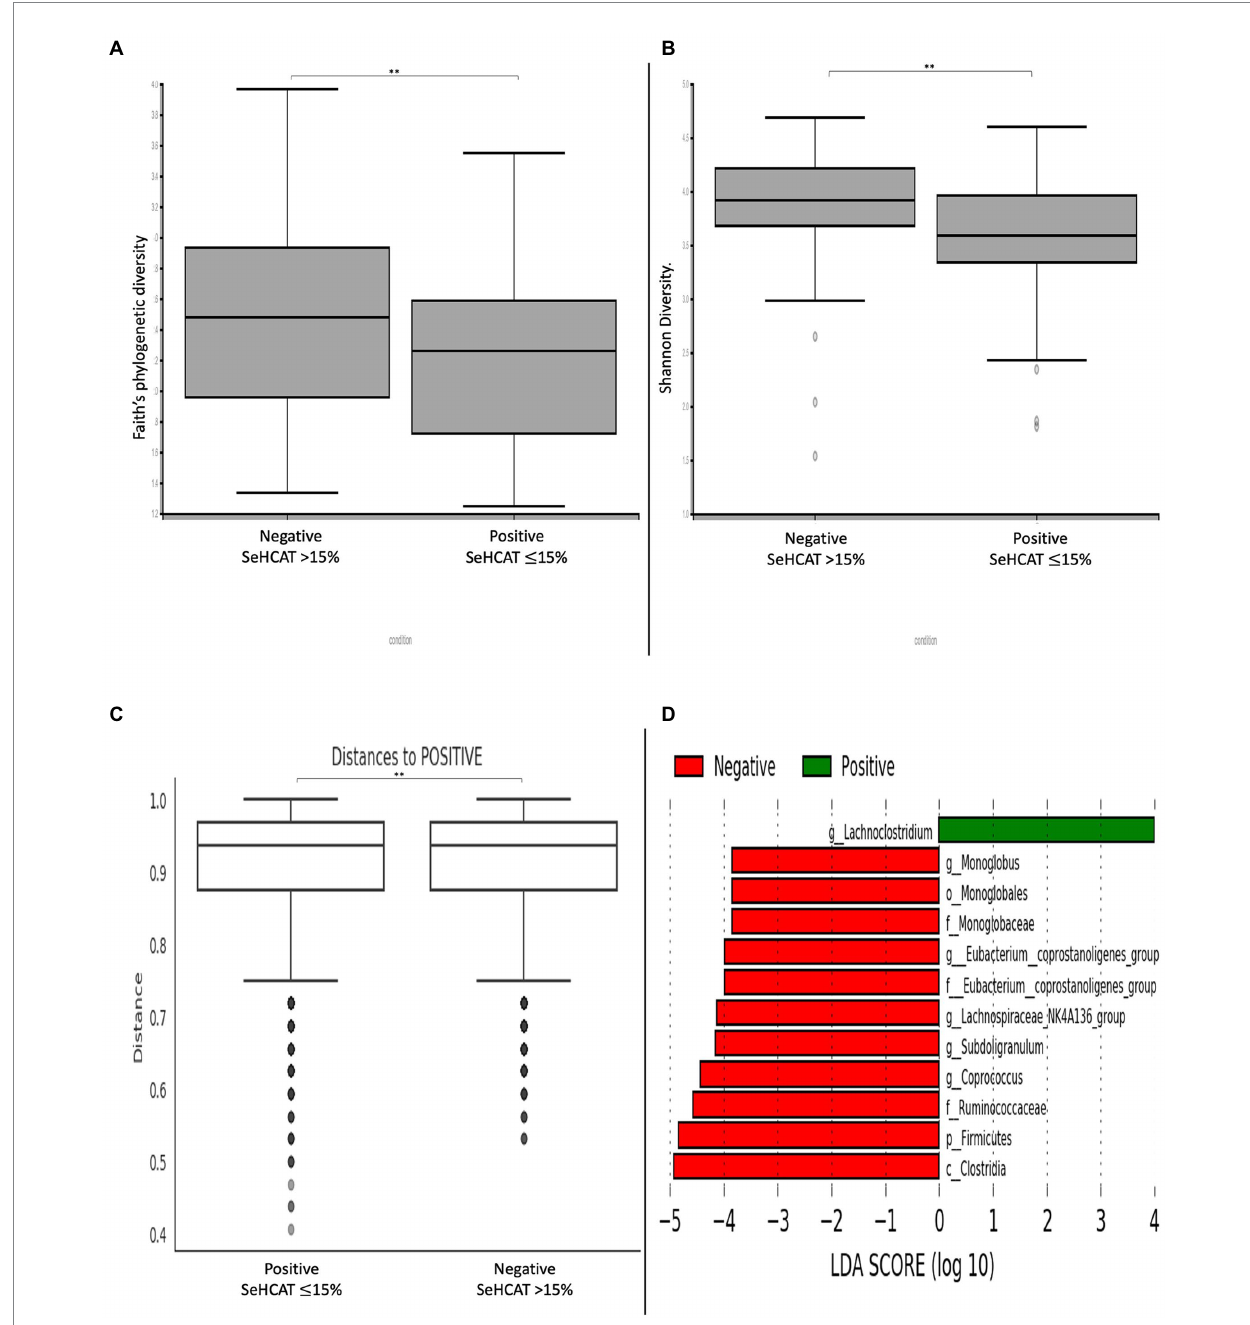
FIGURE 1 Changes in diversity and microbial composition in patients with and without BAD. α -diversity metrics (A) Faith’s phylogenetic diversity. (B) Shannon diversity. (C) β -diversity demonstrated by Bray-curtis distance matrix shows significantly distinct bacterial clusters between positive and negative BAD patients. (D) LEfSE histogram of LDA scores for differentially abundant bacterial taxa between positive and negative patients with BAD. Taxa highlighted in green was more abundant in patients with BAD and red in patients without BAD. Taxa with an LDA > 2 with a p -value ≤ 0.05 was considered statistically significant. ** p -value <